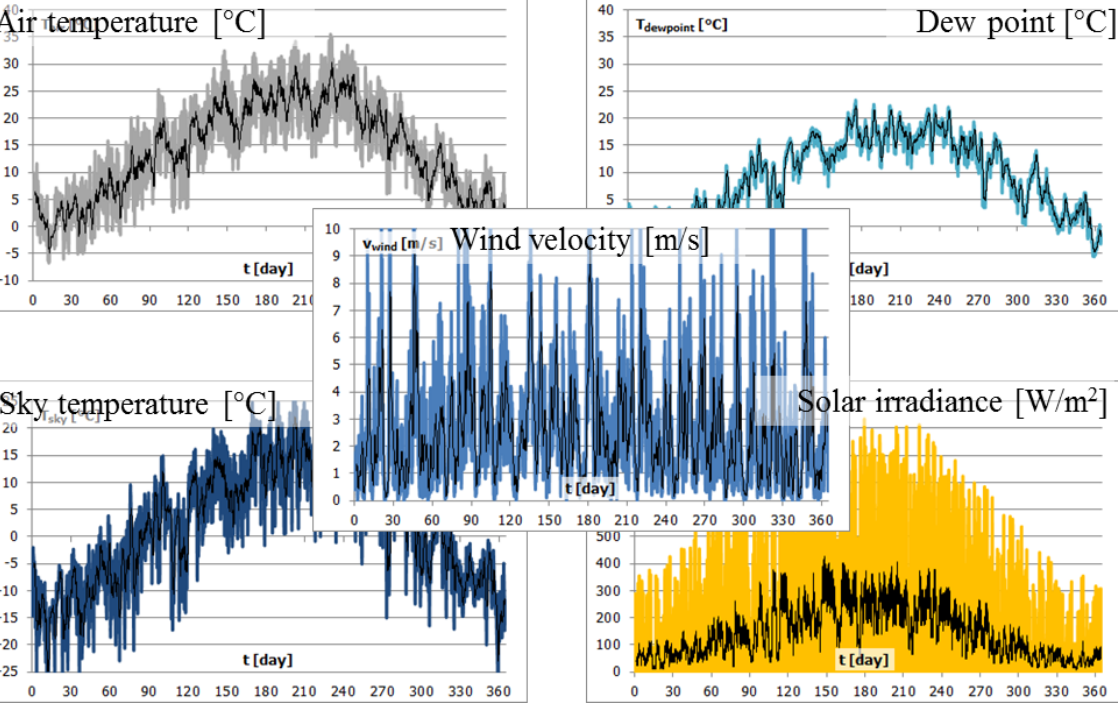
Figure 2. Ambient conditions over the year for Bologna, Italy (data from TRNSYS, the black lines represent the daily average).